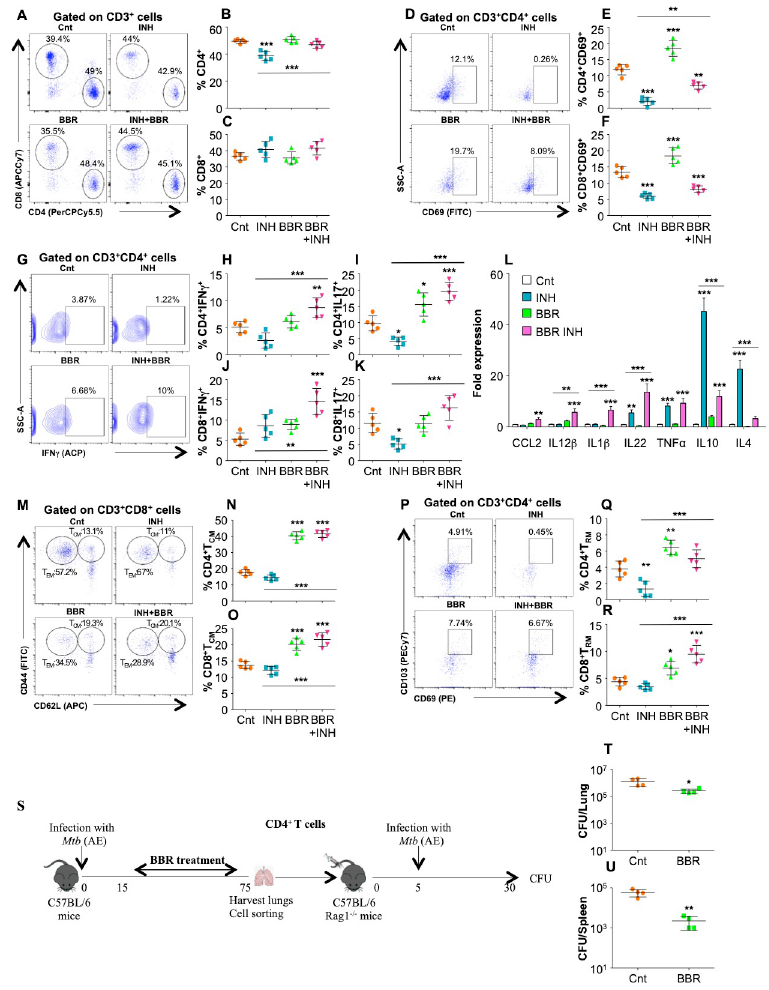
Fig 2. BBR strengthens M . tb -specific T cell responses during TB treatment. Single cell suspensions generated from the infected lungs were ex vivo stimulated with M . tb complete soluble antigen (CSA) for 16 h followed by surface staining with antibodies against CD3 (Pacific Blue), CD4 (PerCPCy5.5), CD8 (APCCy7) and CD69 (FITC) followed by flow cytometry. (A) FACS scatter dot plots and percentage of (B) CD4 + and (C) CD8 + T cells in the infected lungs. (D) Representative FACS dot plot and the percentage of (E) CD4 + CD69 + and (F) CD8 + CD69 + T cells in the infected lungs. (G-K) After stimulation with CSA, the lung cells were treated with monensin and brefeldin A for 2 h and surface stained with α -CD3 (Pacific Blue), α -CD4 (PerCPCy5.5) and α -CD8 (APCCy7) followed by intracellular staining with α -IFN γ (APC) and α -IL17 (PECy7) and flow cytometry. (G) Representative dot plots and percentage of (H) CD4 + IFN γ + , (I) CD4 + IL17 + , (J) CD8 + INF γ + and (K) CD8 + IL17 + cells in the infected lungs. (L) Fold expression of cytokines in the lungs of infected, INH and BBR treated splenocytes. (M-R) To determine the frequency of central memory and resident memory T lymphocytes, ex vivo stimulated lung cells were surface stained with α -CD3 (Pacific Blue), α -CD4 (PerCPCy5.5), α -CD8 (APCCy7), α -CD69 (PE), α -CD103 (PECy7), α -CD62L (APC) and α -CD44 (FITC) followed by flow cytometry. (M) Representative FACS dot plots and (N) the percentage of CD4 + T CM (CD62L HI CD44 HI ) cells, T cell subset. (O) Percentage of CD8 + TCM (CD62L HI CD44 HI ) cells, in the infected lungs with or without drug treatment. (P) Representative scatter dot-plot images and percentage of (Q) CD4 + TRM and (R) CD8 + TRM cells in the lungs of infected mice. (S) Schematic representation of adoptive transfer experiment. CFU enumeration after 21 days of adoptive transfer in (T) the lungs and (U) the spleen of Rag-/- mice. Data is representative of two independent experiments. The data values represent mean ± SD (n = 5). � p < 0.05, �� p < 0.005, ��� p <